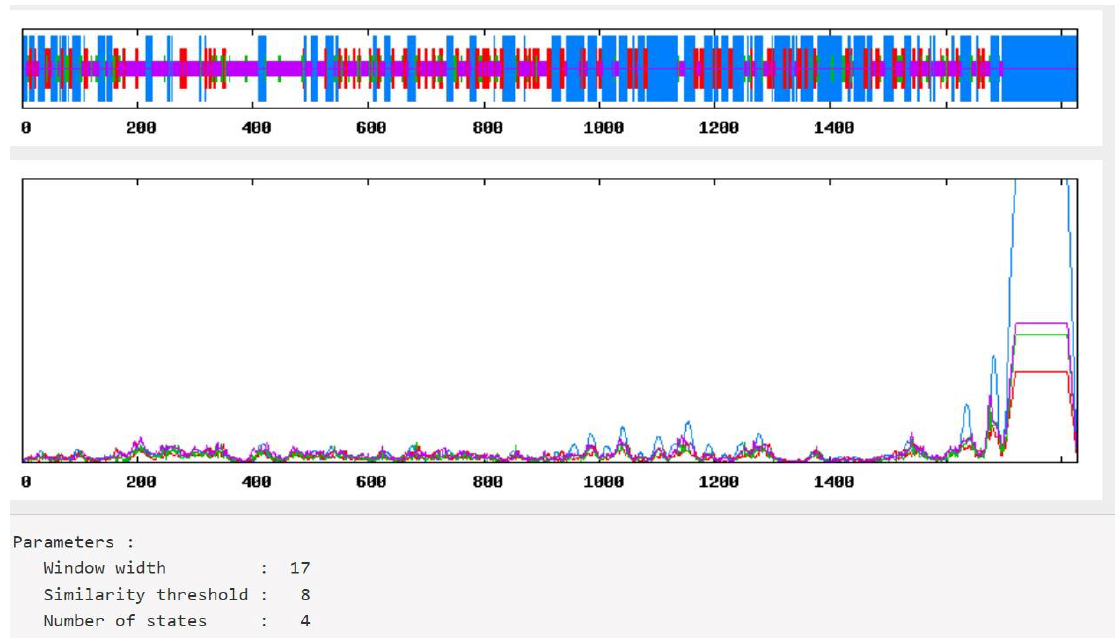
Figure 4. Secondary structure prediction of vaccine construct.